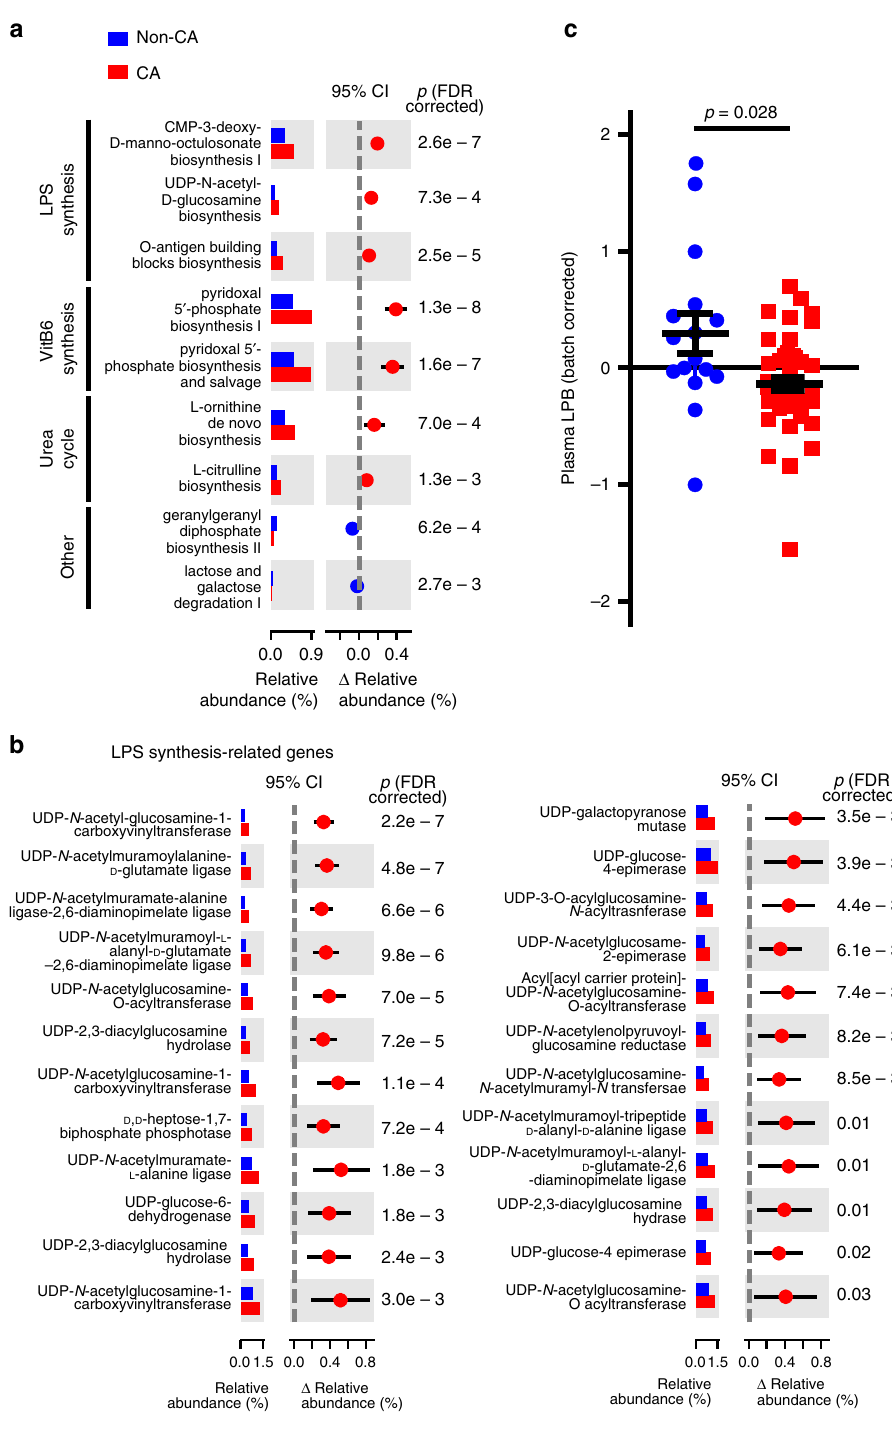
Fig. 2 Fecal LPS synthesis pathway is upregulated in CA patients. a Metagenomic shotgun data were used to compare relative gene abundance of bacterial metabolic pathways. Relative abundances of signi fi cantly different metabolic pathways are shown ( n = 27 non-CA, n = 121 CA, two-sided Mann – Whitney U test with Benjamini – Hochberg FDR correction). b Relative abundance of signi fi cantly different LPS synthesis pathway-related genes between non-CA and CA individuals (two-sided Mann – Whitney U test with Benjamini – Hochberg FDR correction). c Batch-corrected LPB content in peripheral plasma of non-CA and CA individuals ( n = 16 for non-CA, n = 47 for CA individuals, two-tailed unpaired t test with Welch ’ s correction). Average data are presented as mean ± s.e.m. Blue: non-CA individuals, red: CA